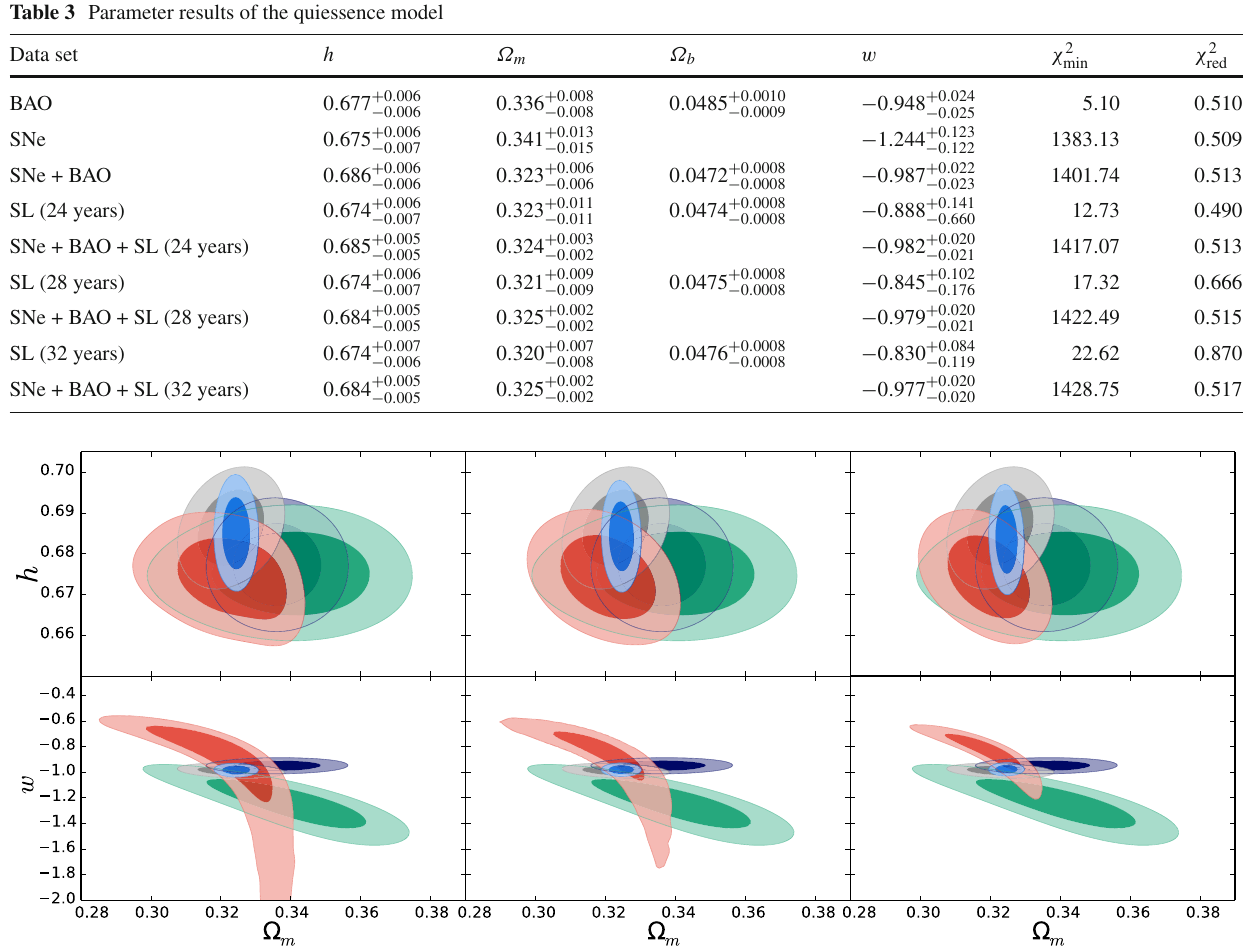
Fig. 5 Quiessence model; solid contours limit 1 σ regions and clear contours 2 σ region. Purple for the BAO, green for SNe and red for SL data set, gray for SNe + BAO and blue SL + BAO + SNe. First set (left) for 24 years, second (middle) for 28 and third (right) for 32